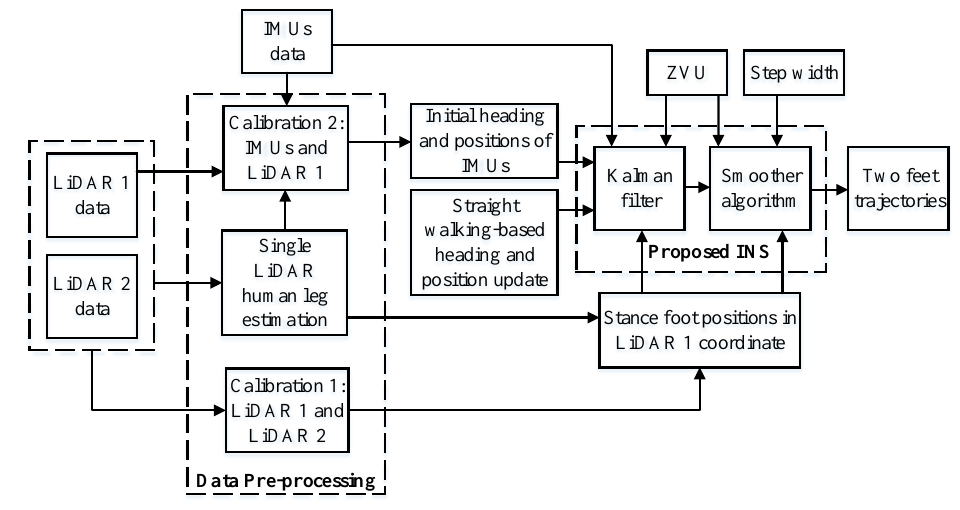
Figure 2. Block diagram of proposed method.